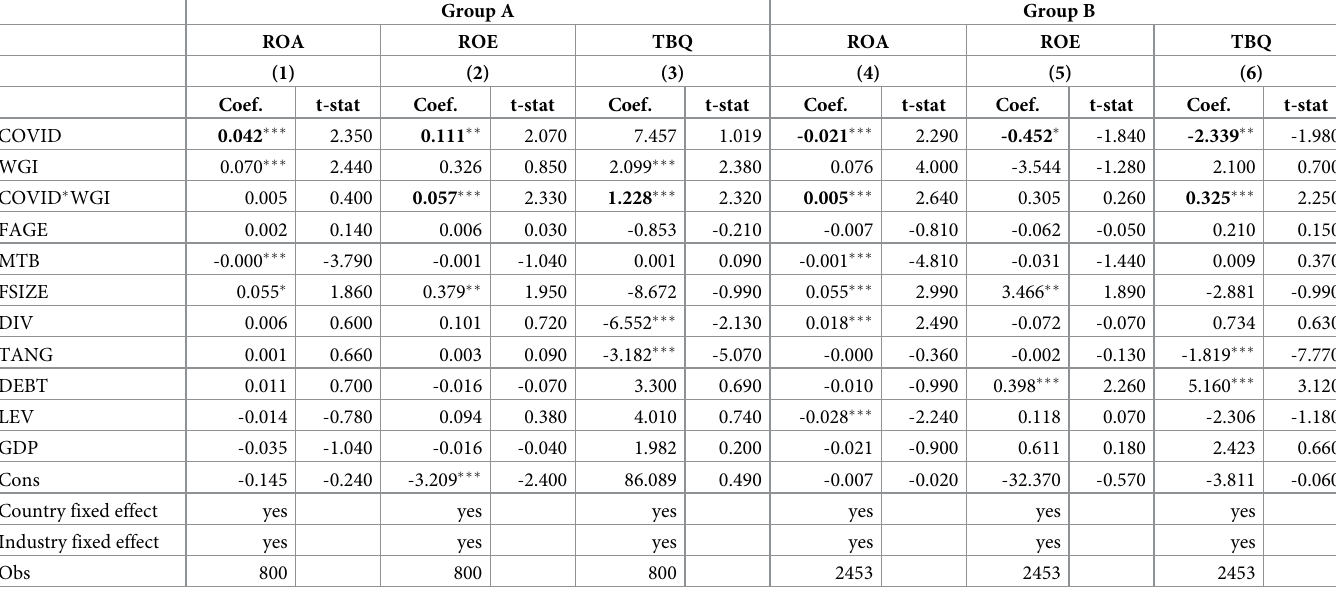
Table 7. COVID-19 crisis and firm performance by